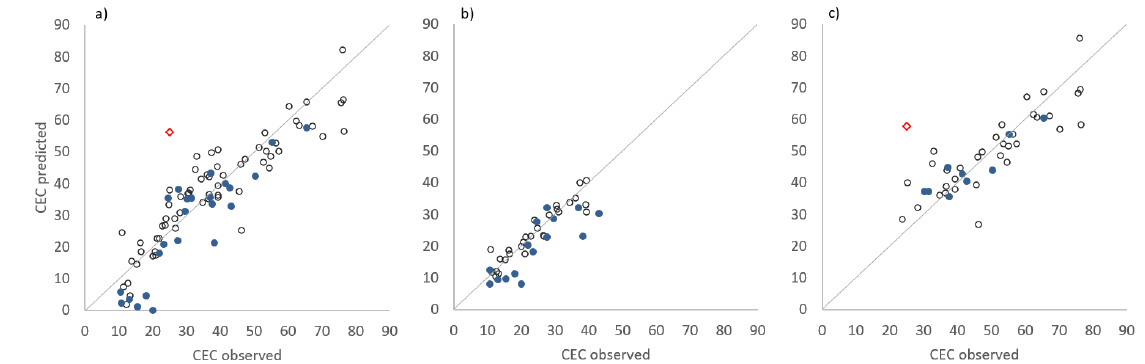
Fig. 1. Predicted cation exchange capacity (CEC, cmol(+) kg -1 ) modelled using soil test cations (STCat cmol(+) l -1 = STCa cmol l -1 × 2 + STMg cmol l -1 × 2 + STK cmol l -1 ) and pH as predictors for a) the whole data, b) for mineral soils and c) for organic soils plotted against observed CEC (cmol(+) kg -1 ). Open circles represent the results of the calibration data and blue circles represent the validation data. Data point excluded from the regression analysis as an outlier is marked with red square.